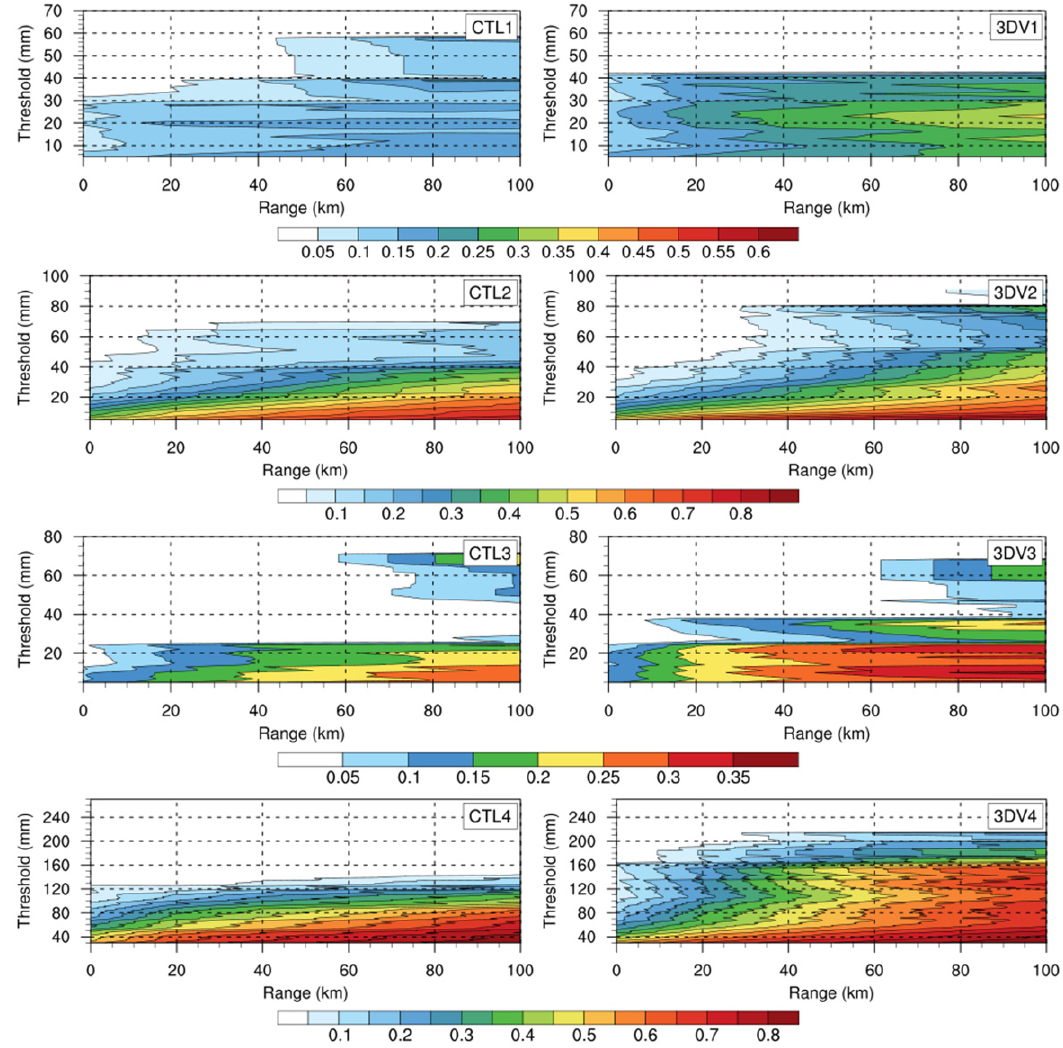
Figure 7. FSS scores for the CTL and 3DV experiments in Cases 1–4. The numbers included in the panels indicate the corresponding case number.